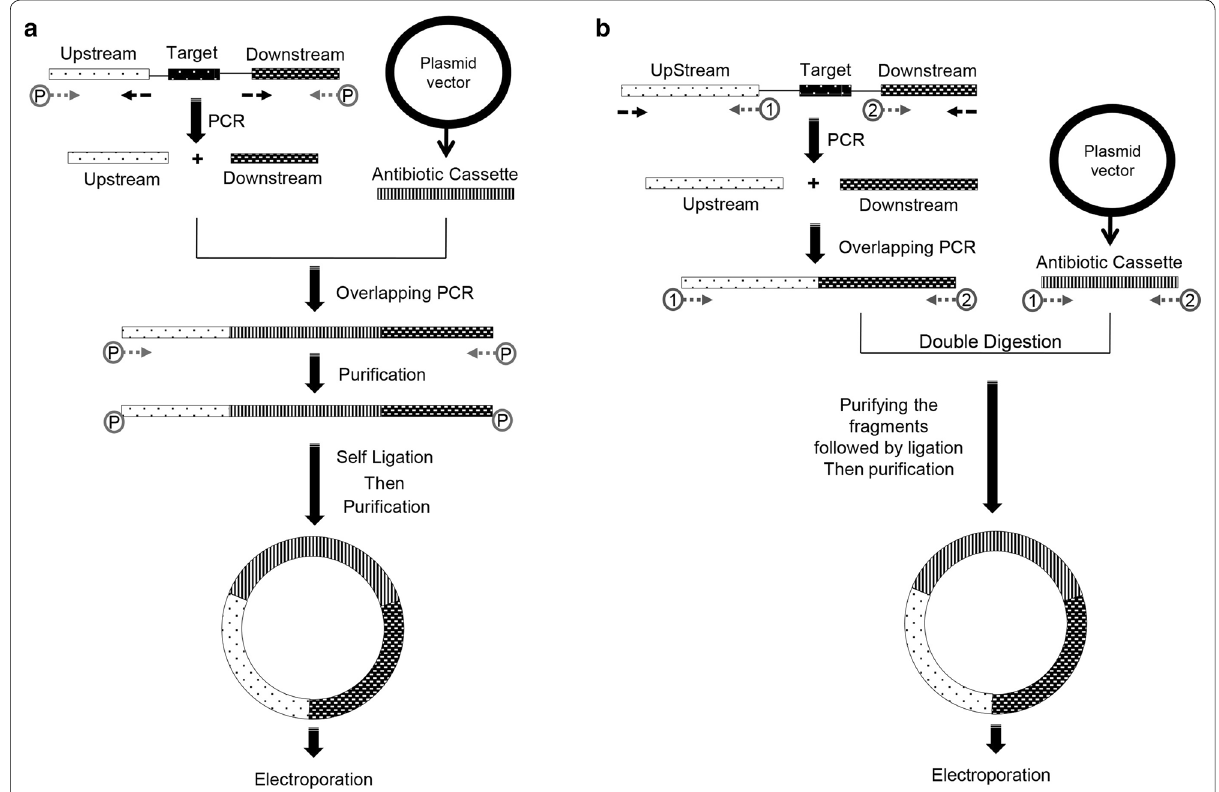
Fig. 1 Schematic representation showing the procedures of the original VFAE protocol ( a ), and the new modifications of the enhanced protocol ( b